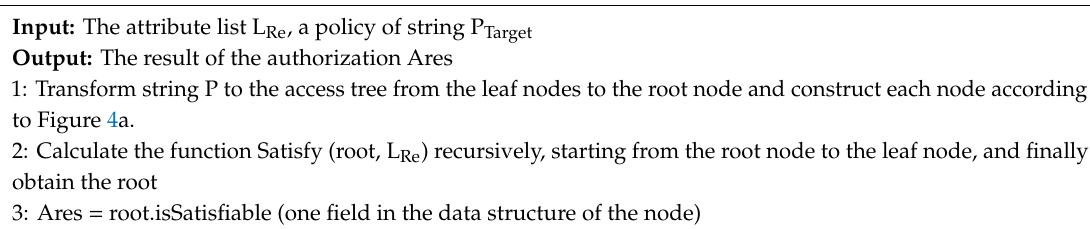
Algorithm 2 Make the authorization